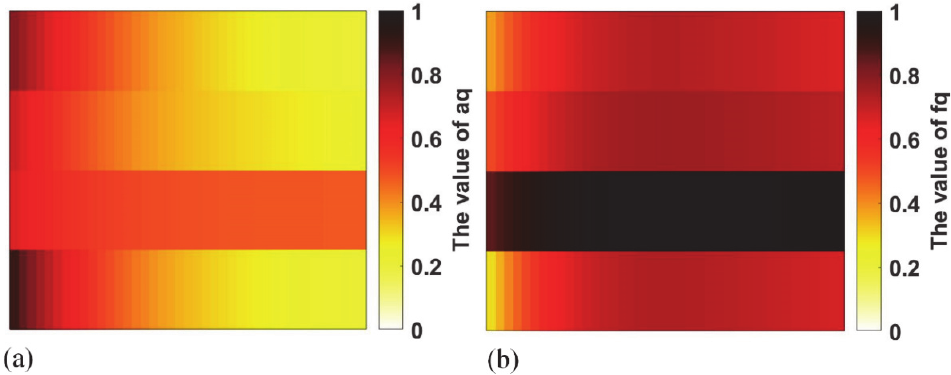
Figure 6. Normalize values of 𝛼(𝑞) and 𝑓(𝑞) , convert them into chromaticity diagrams: ( a ) 𝛼(𝑞) and ( b ) 𝑓(𝑞) of the first column.